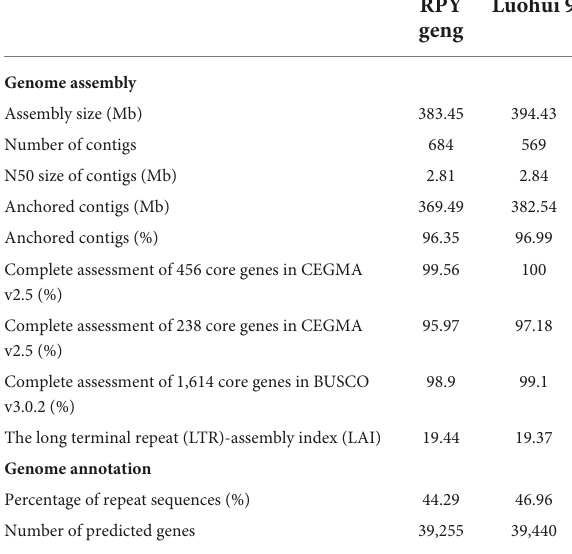
TABLE 1 Summary of genome assembly and annotation of RPY geng and Luohui